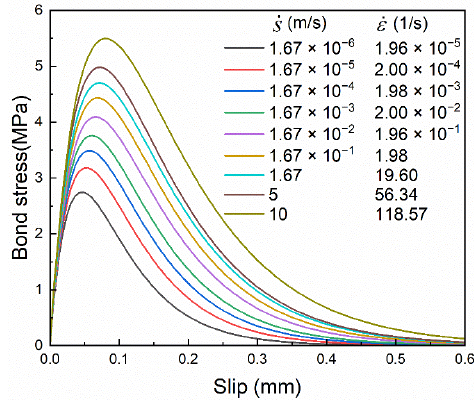
Figure 24. Load–slip curves under different slip rates. Figure 25. Bond–slip curves under different slip